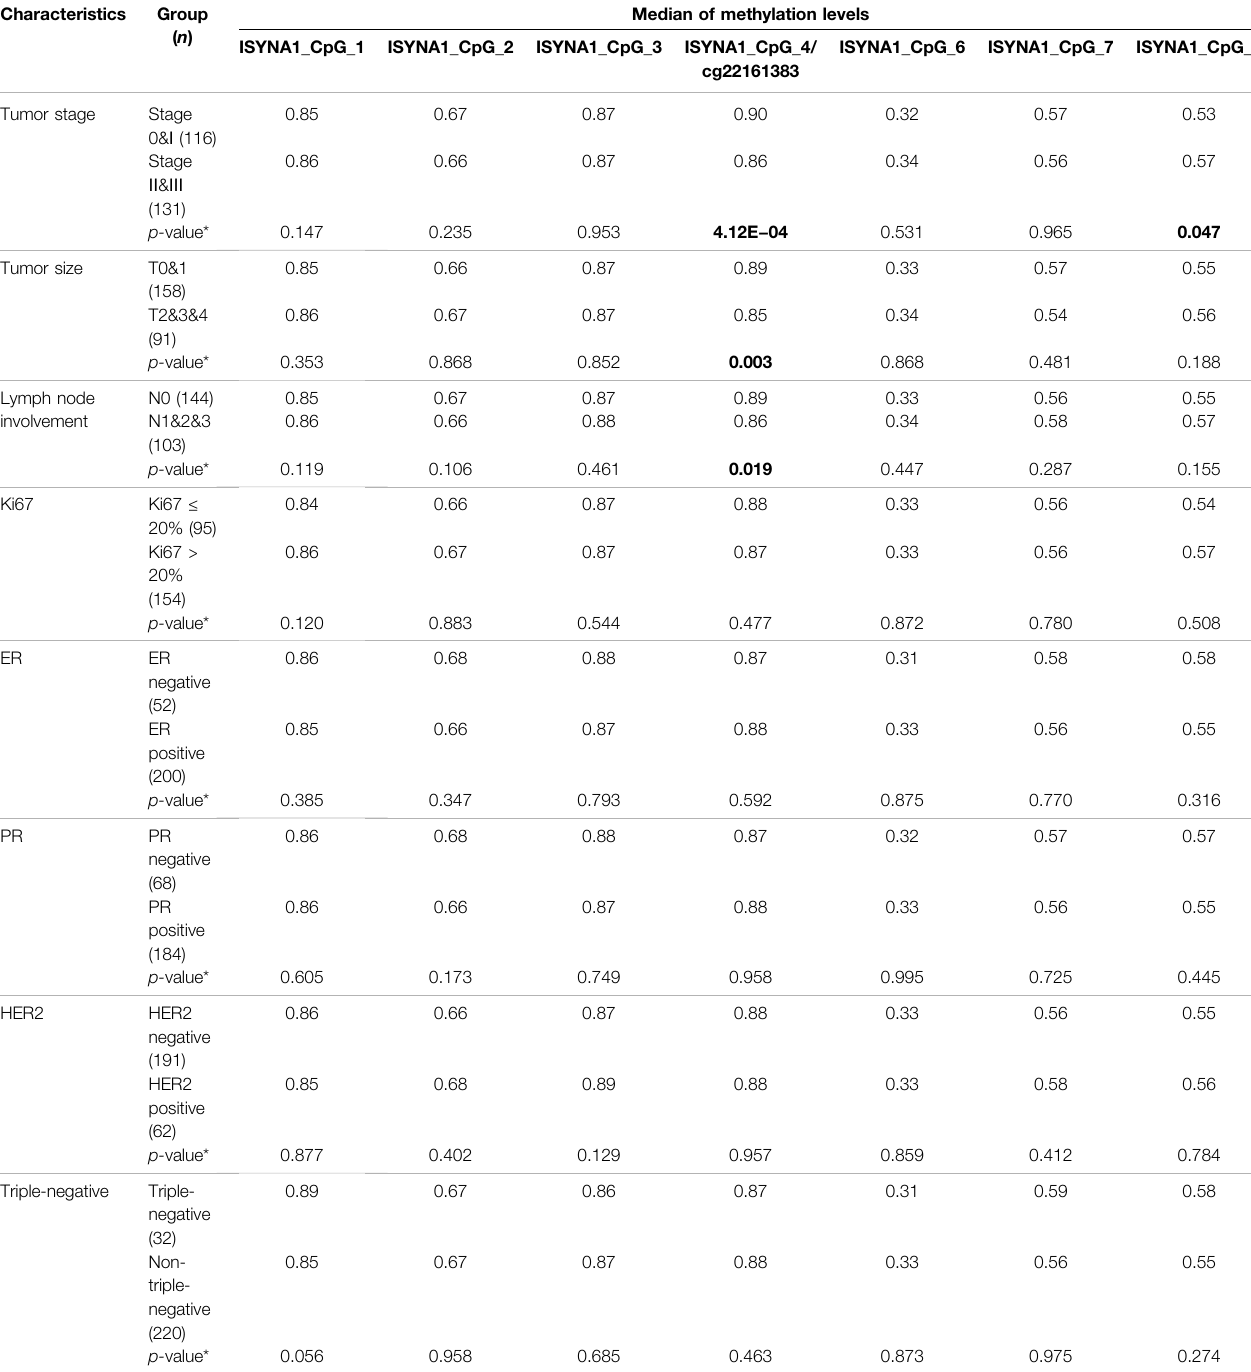
TABLE 5 | Correlation between ISYNA1 methylation and the clinical characteristics of sporadic BC cases combining validation I and validation II.